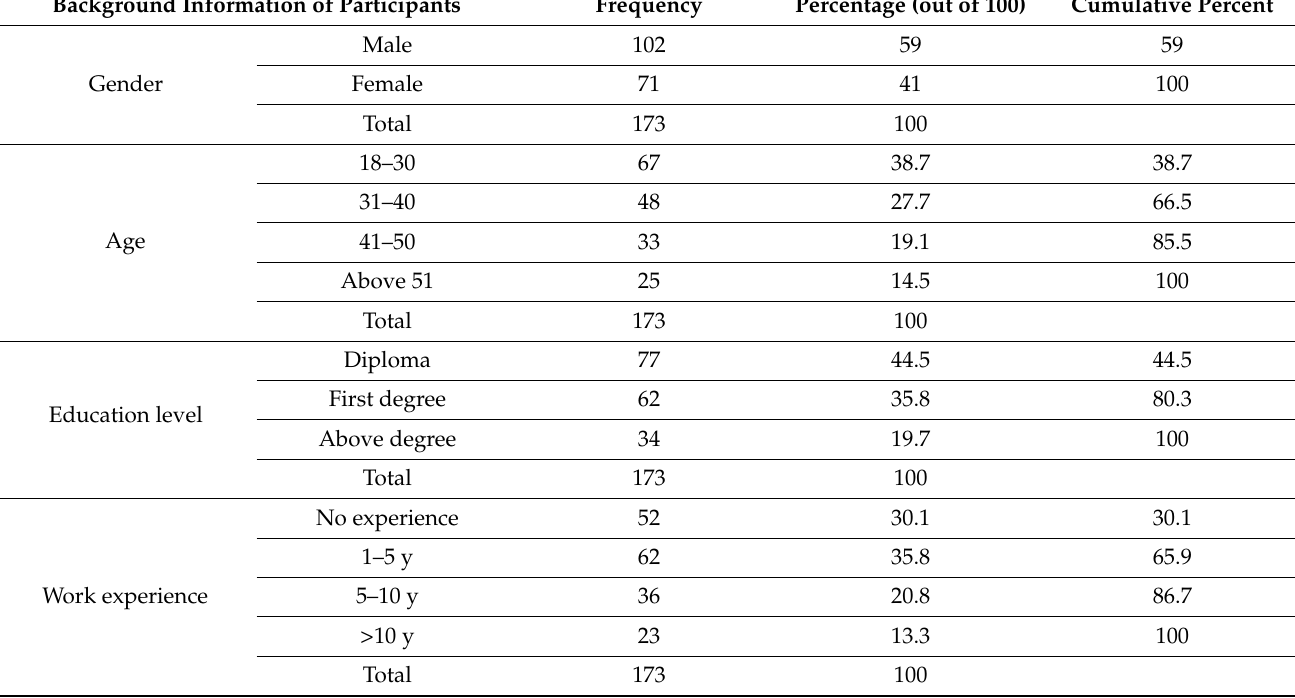
Table 4. Respondents’ demographic